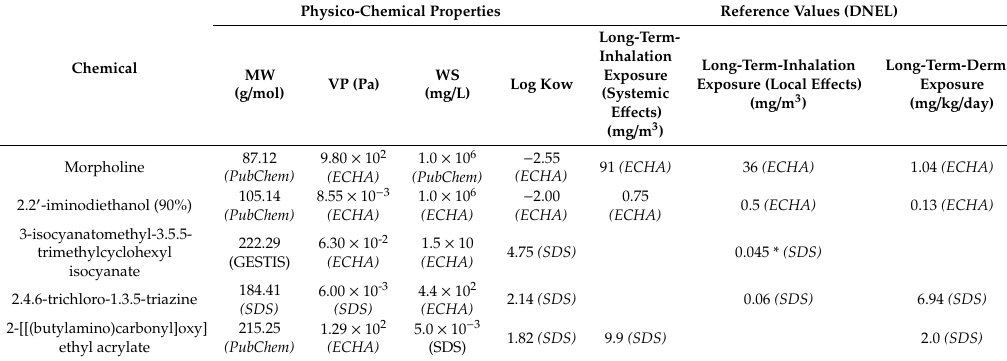
Table 2. Physico-chemical properties of the chemicals considered in this study and associated reference values for each route of exposure. Note: * = DNEL / DMEL; Sources: GESTIS = substance database (IFA, Berllin, Denmark; www.dguv.de / ifa / gestis-database), PubChem = (https: // pubchem.ncbi.nlm.nih.gov / ); ECHE = European Chemical Agencies Registered substances factsheets (https: // echa.europa.eu / search- for-chemicals); SDS = chemical’s (extended) safety data sheet, as provided by the supplier. Physico-Chemical Chemical